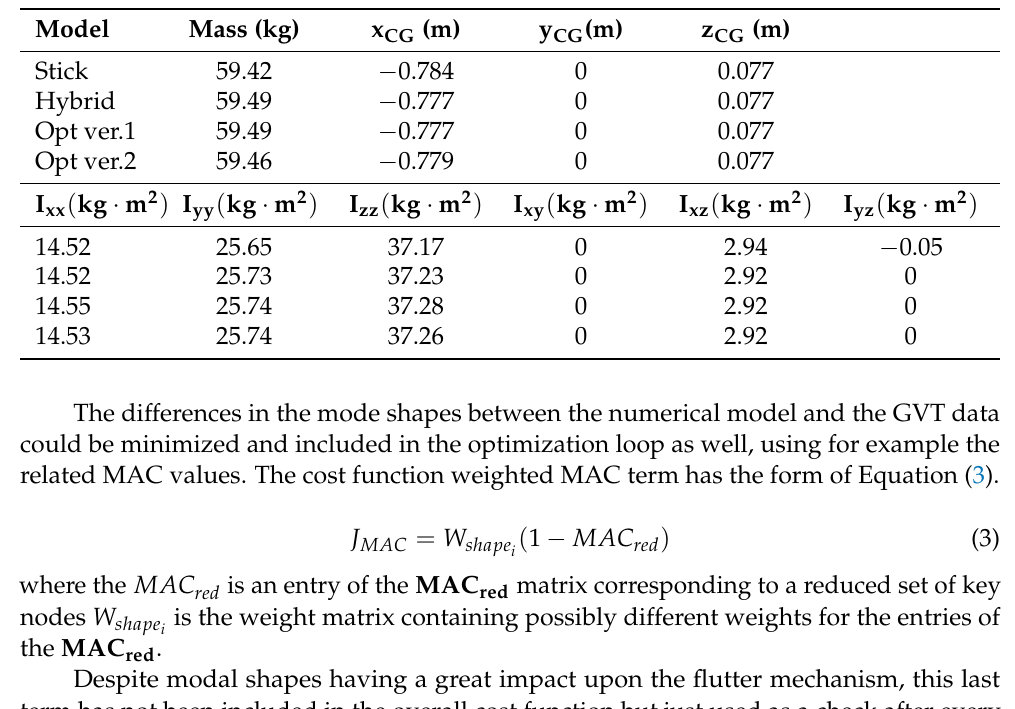
Table 4. Mass properties of the FEM